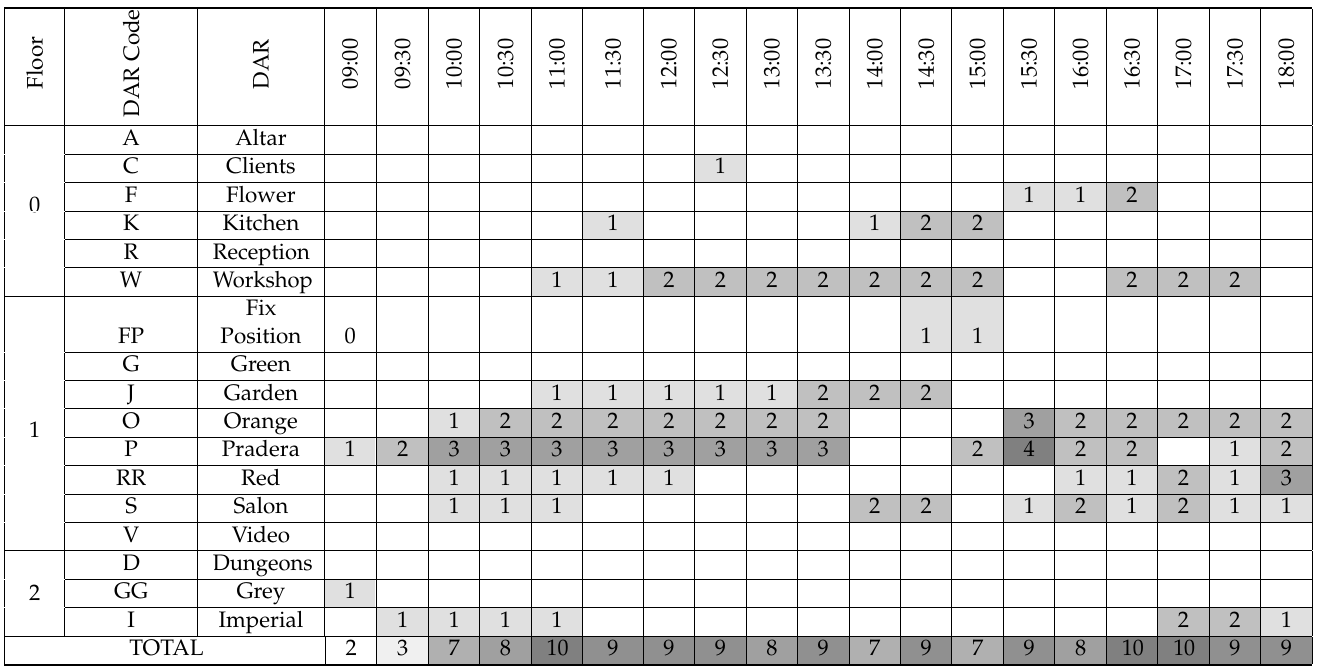
Table 6. Design team presence per DAR. Numbers indicate the number of employees from design team present at each spaces per hour. Dark colors highlight the areas with more users present at a time.